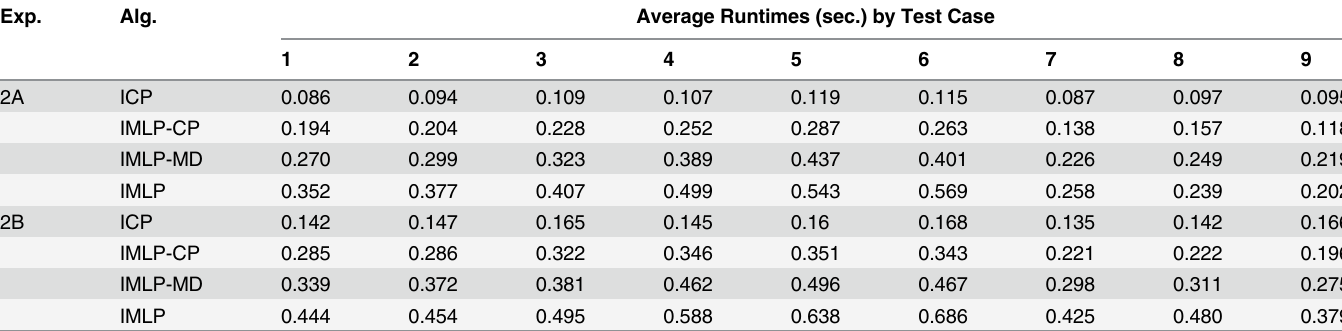
Table 6. Runtimes for registering a mesh target shape. (Experiment 2). Exp.